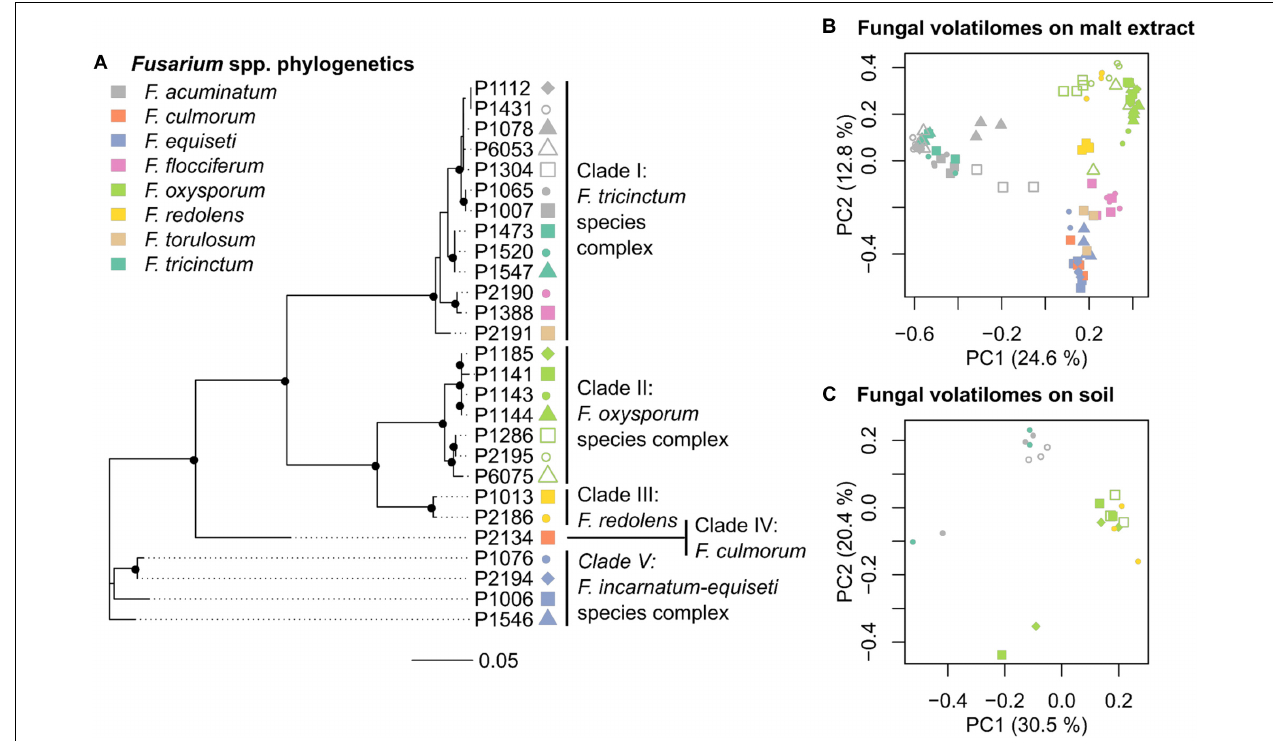
FIGURE 2 | Phylogeny and volatilome of Fusarium spp. (A) Phylogenetic tree of 27 Fusarium strains based on partial tef-1 α sequences ( Table 1 ). Black dots in the tree nodes indicate bootstrap values ≥ 70% based on 1,000 replicates. (B) Principle Coordinate Analysis (PCoA) based on the VOC profiles of 27 Fusarium strains grown in malt extract ( n = 3–4 replicates per strain) (C) PCoA based on the VOC profiles of 7 Fusarium strains grown in soil ( n = 3 replicates per strain). Each point in PCoAs correspond to an independently measured volatile profile, with point color indicating the species (see color key), and different point types within each clade denoting different strains. Both PCoAs highlight that differences in VOC profiles among strains correspond by large to genotypic